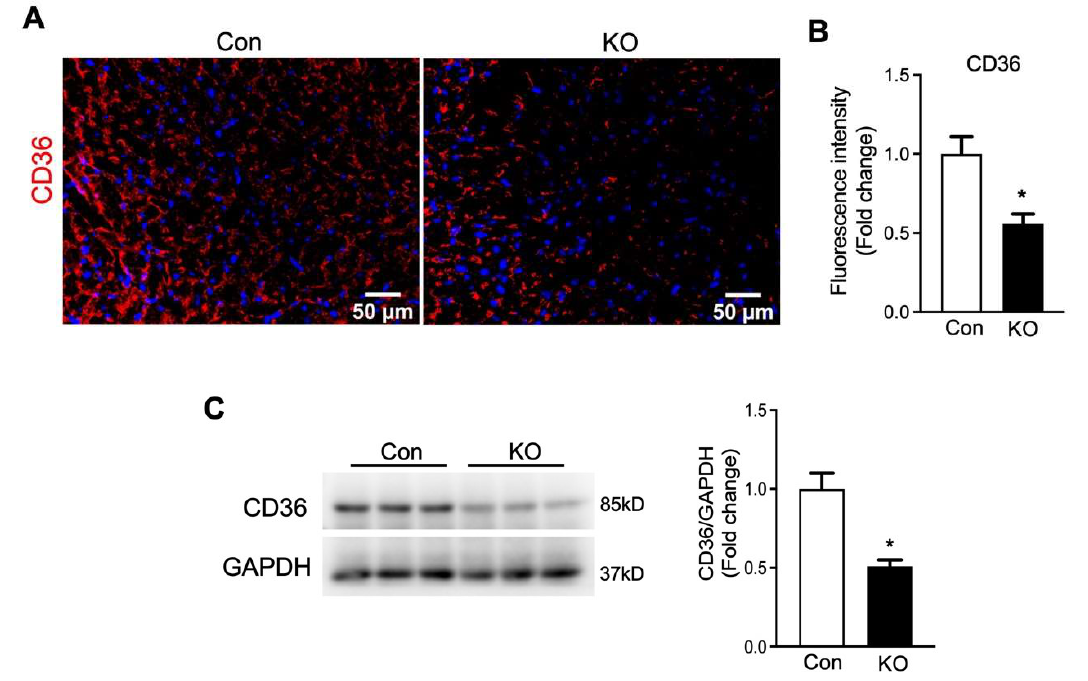
Figure 7. Deletion of adipose CGI-58 decreased cardiac CD36 protein level in chow-fed mice after cold stress. ( A , B ) Representative images and fluorescence intensity analysis of immunofluorescence staining of CD36 (red) with DAPI (blue) in the cardiac tissues of the mice described under Figure 4. Quantification of fluorescence intensity was performed in three to five randomly selected microscopic fields per heart under 20× magnification ( n = 4 mice/group). ( C ) Cardiac protein levels of CD36 in the mice described under Figure 4. * p < 0.05 vs. genotype by two-tailed unpaired Student’s t -test.